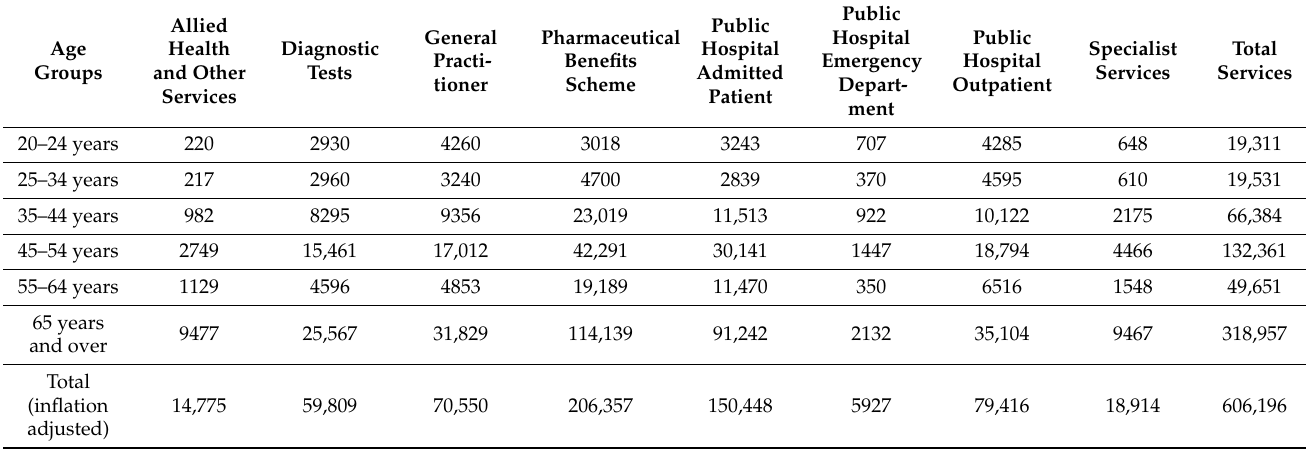
Table A14. Extra costs incurred due to LHL for people diagnosed with Endocrine disorders in the Blacktown LGA (Domain